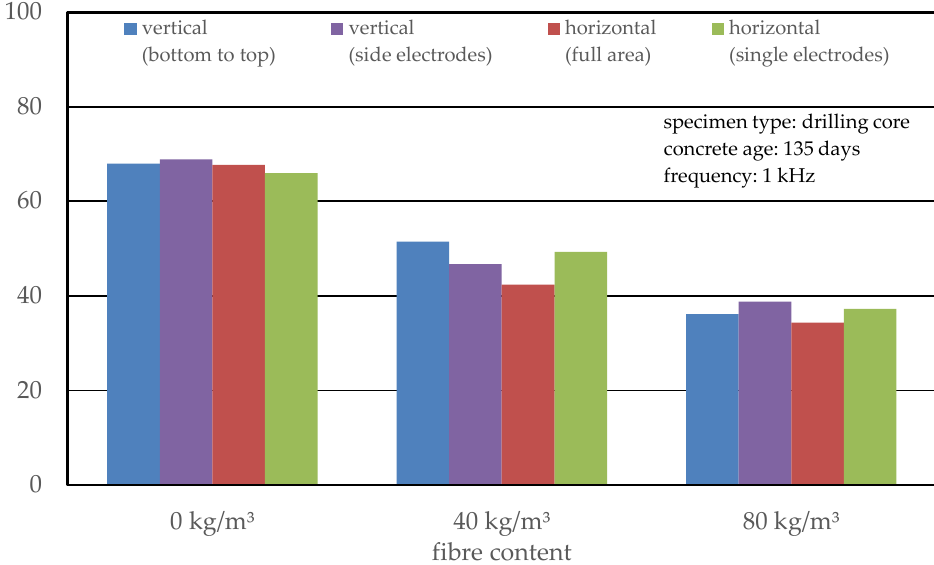
Figure 12. Calculated electrical resistivity of drilling cores depending on the fibre content.